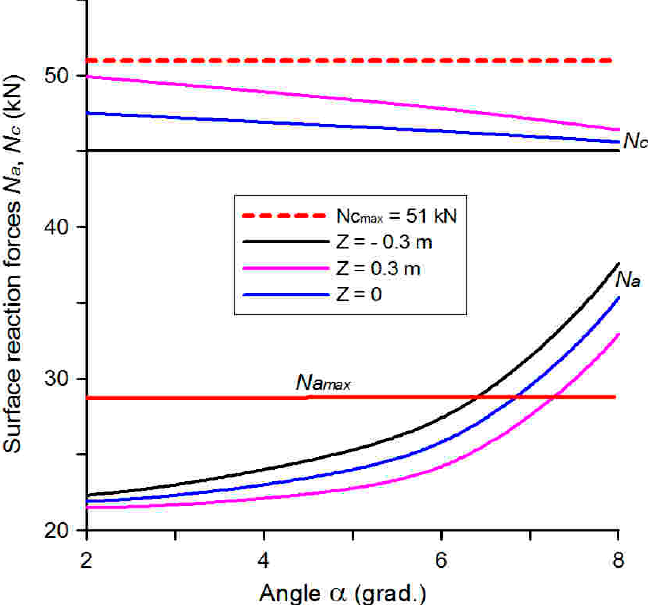
α of the central link of the